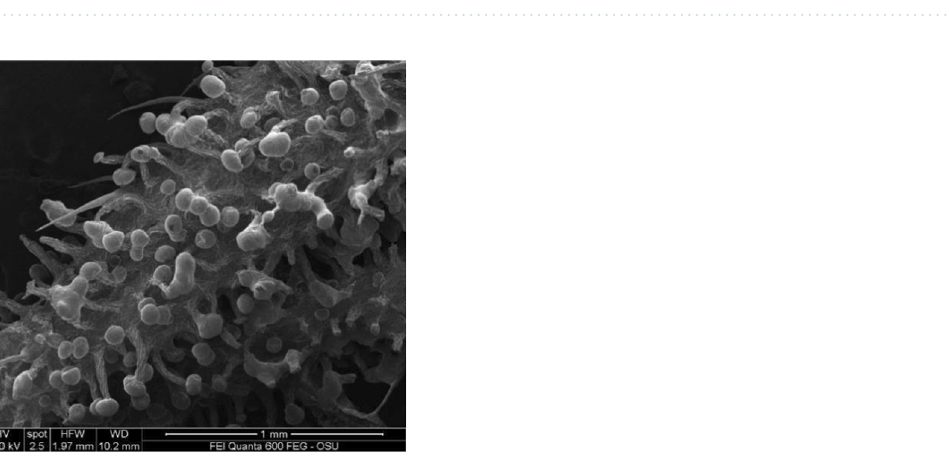
Figure 1. ( A ) Hemp abaxial (lower) leaf surface with glandular trichomes, and slender cystolithic non glandular trichomes. ( B ) Hemp adaxial (upper) leaf surface with an abundance of cystolithic trichomes and few sessile glandular trichomes. ( C ) Hemp leaf petiole with an abundance of cystolithic and slender non glandular trichomes and few sessile glandular trichomes. ( D ) Flower bract densely covered with glandular trichomes. ( E ) Close up of flower bract with glandular trichomes and slender non glandular trichomes. ( F ) Detached sessile glandular trichomes from hemp leaves.